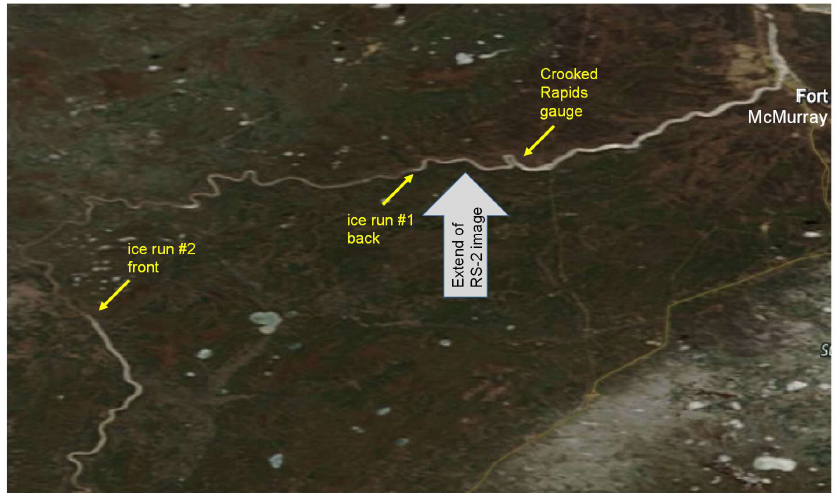
Figure 7. MODIS Terra image acquired 26 April 2018 11:35 MST.